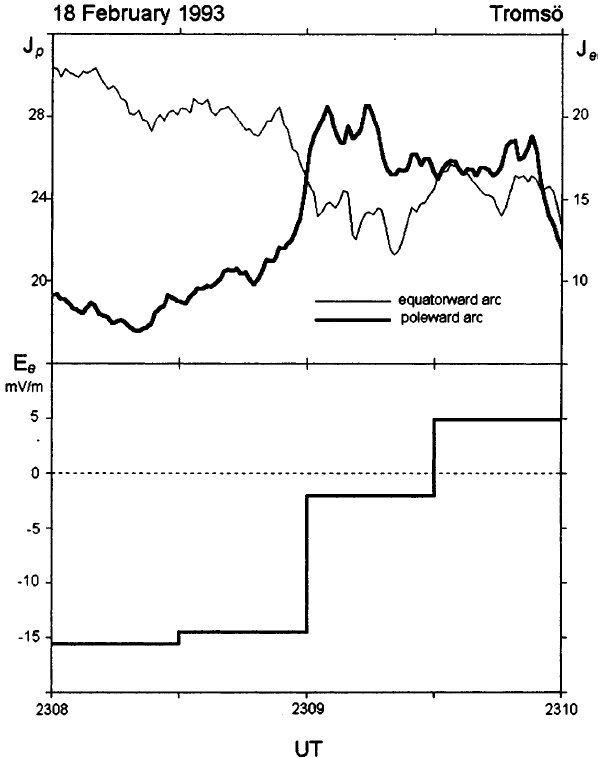
Fig. 8. Variations of the mean value of the luminosity in the system of two parallel auroral arcs ( top panel ) and variation of the azimuthal component of electric field in the ionosphere ( bottom panel ). J means the intensity of the luminosity